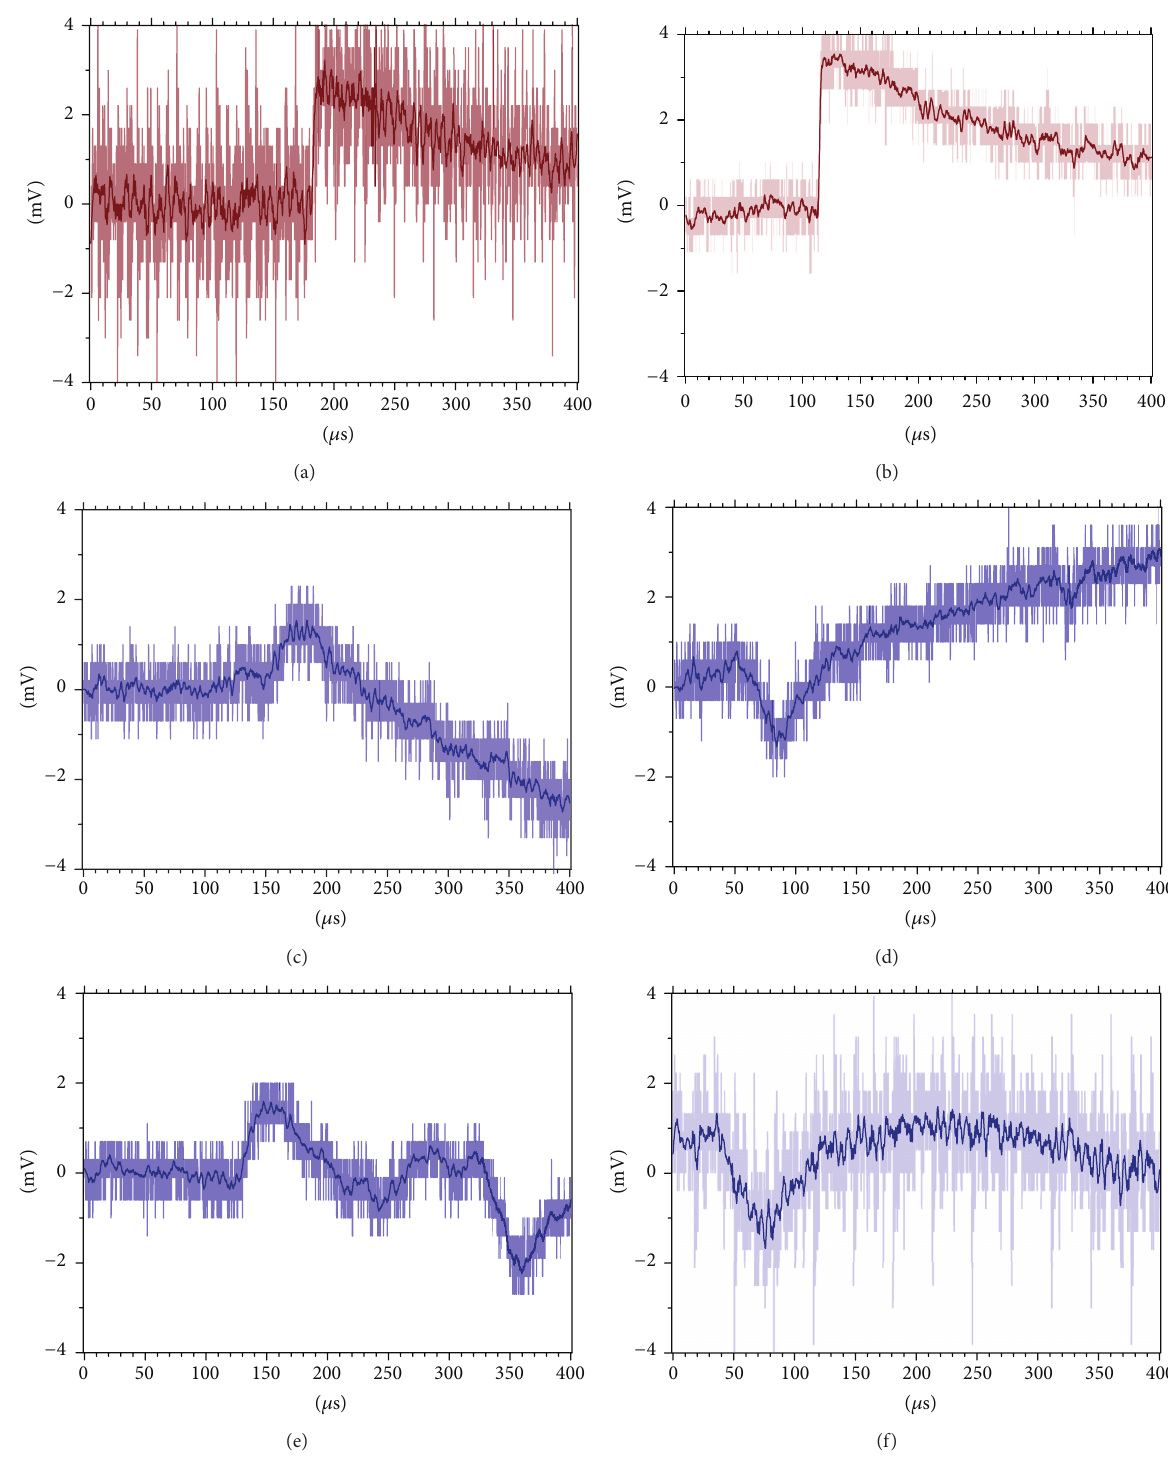
Figure 8: The shapes of the pulses in the time interval 400 𝜇